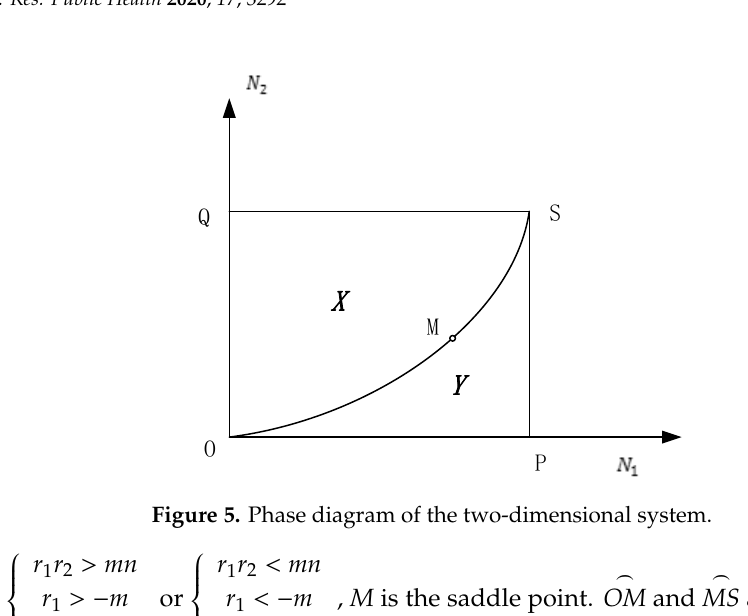
, M is the saddle point. OM and MS are the dividing lines